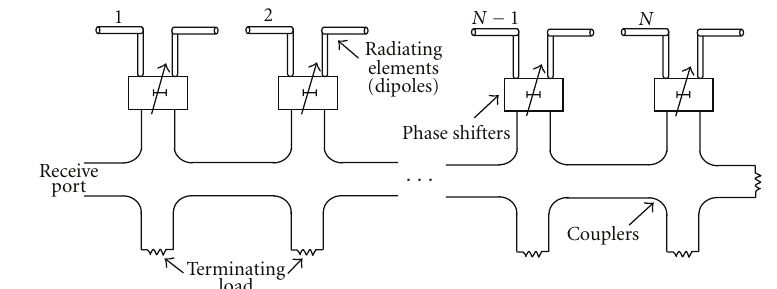
Figure 1: Typical series-fed network of phased array.